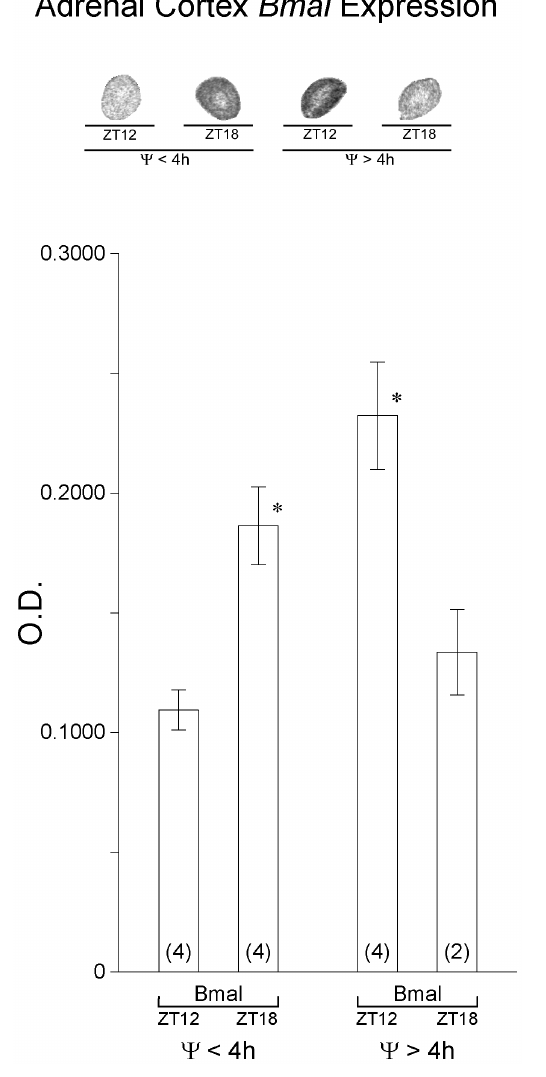
Figure 9. Clock gene expression in the adrenal cortex. (top) Representative autoradiogram images of bmal1 expression in the adrenal cortex measured by in situ hybridization for animals in 8L:14D entrained with Y s # 4 h delayed and Y s . 4 h delayed and killed at ZT 12 and ZT 18. Quantification shows that bmal1 expression is significantly greater at ZT 18 in animals with Y s # 4 h delayed whereas bmal1 expression in significantly greater at ZT 12 in animals with Y s . 4 h delayed indicating the adrenocortical molecular rhythms are in different phases relative to light offset.